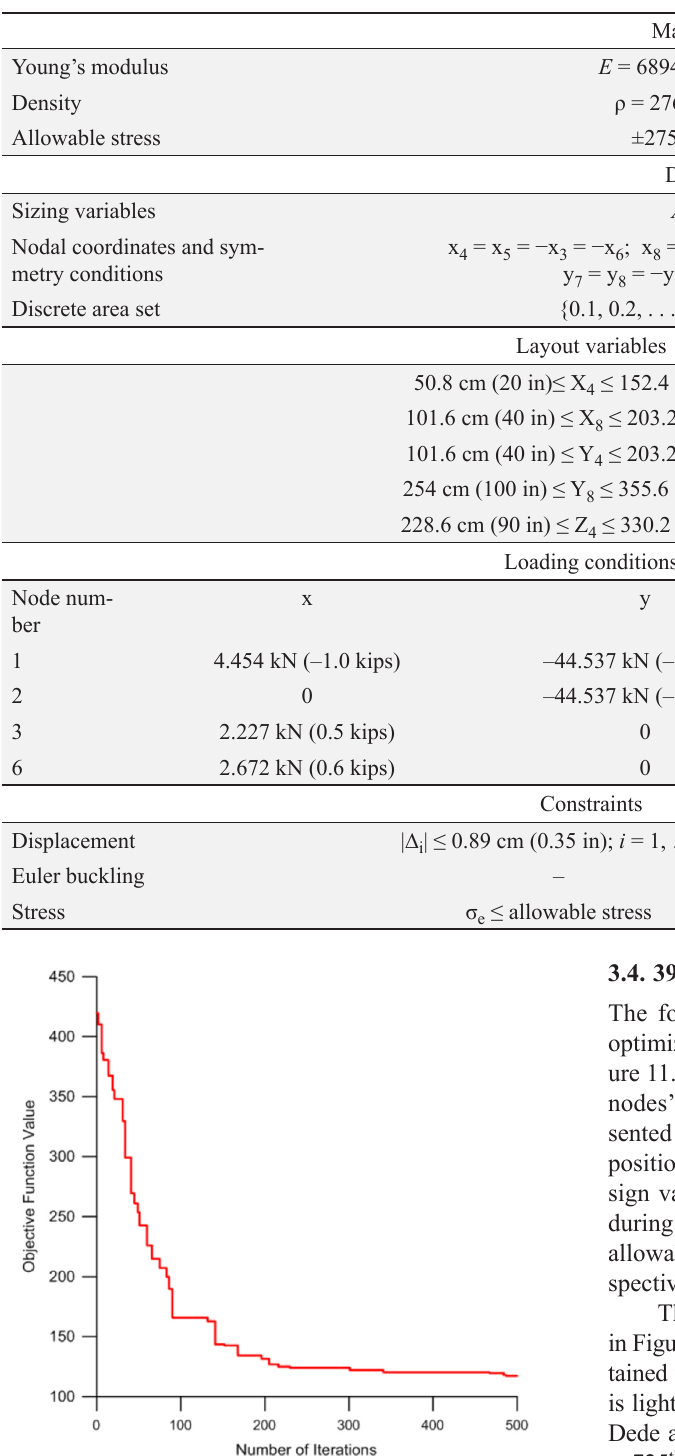
Table 5. Input data for the spatial 25-bar truss problem